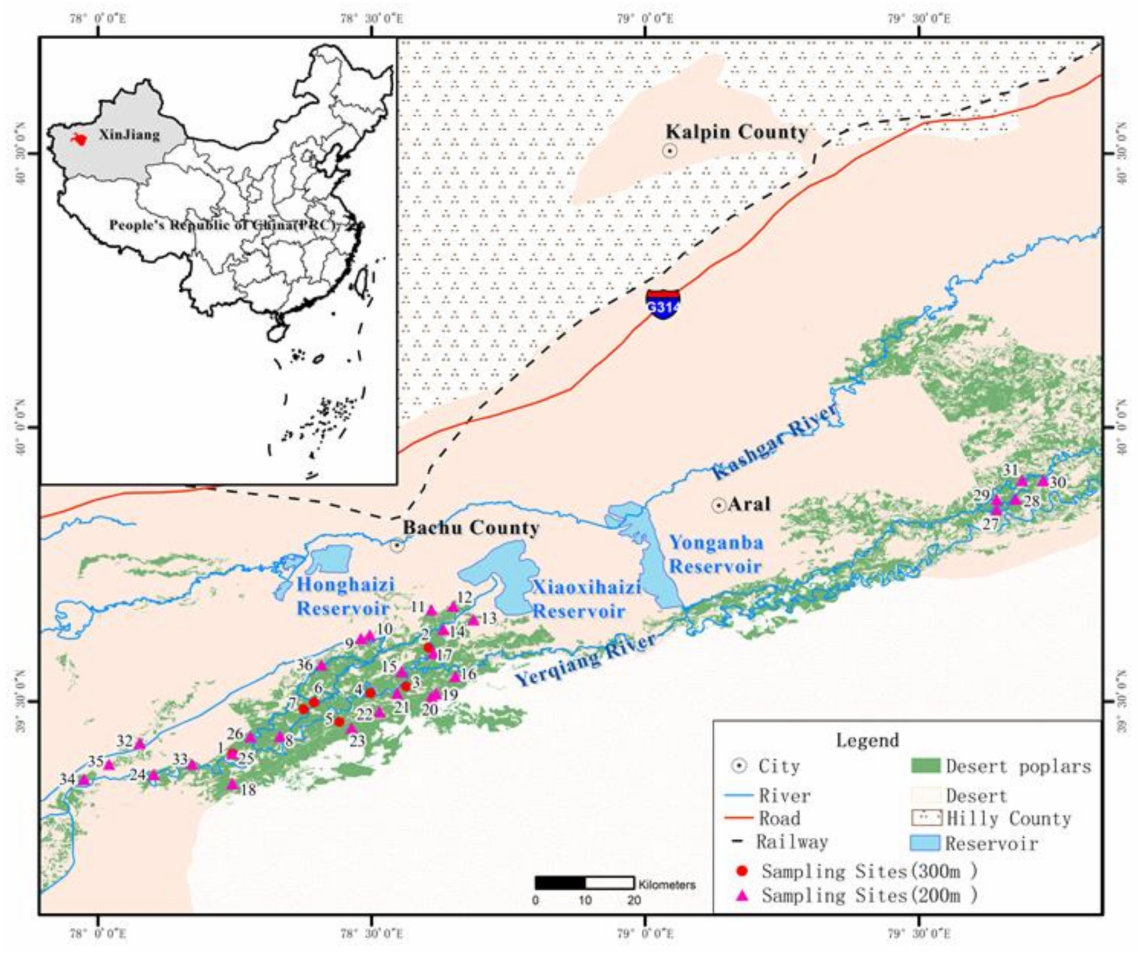
Figure 1. Location of the study